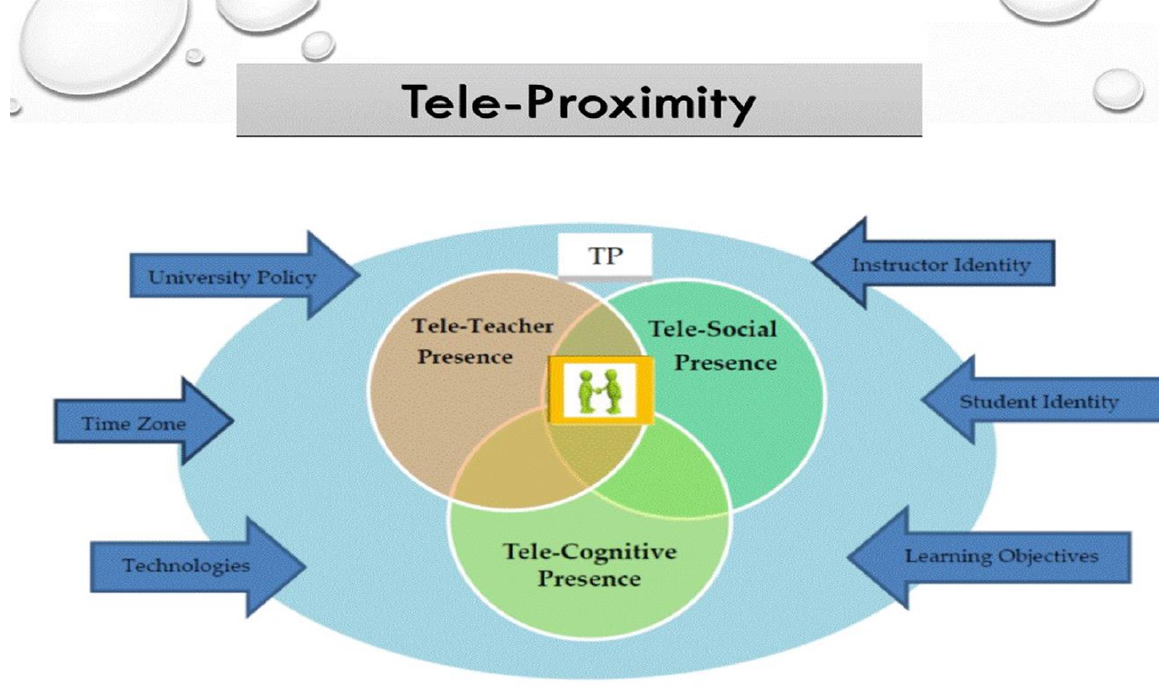
Figure 1.1. Tele-proximity model: The blue section is the stage (SVC context) on which online presences perform while interacting one another in order to build a sense of “place.” The arrows represent different affecting factors that could create the ecosystem of tele-proximity stage. The point where the three dimensions intersect is the educational experience of human-to-human connection that tele-operations